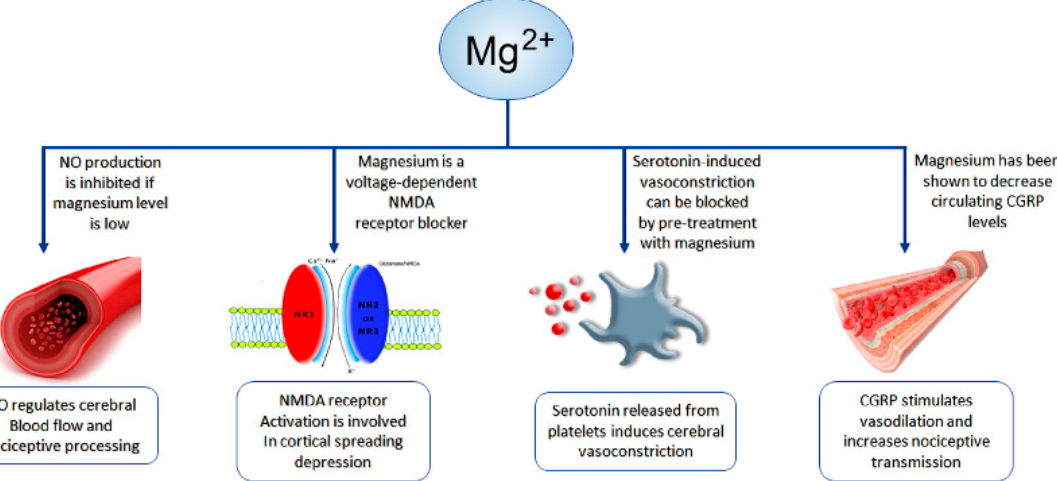
Figure 2. Mechanisms involved in migraine, and the possible role of magnesium. CGRP, circulating calcitonin gene-related peptide; NMDA, N-methyl-D-aspartate; NO, nitric oxide.